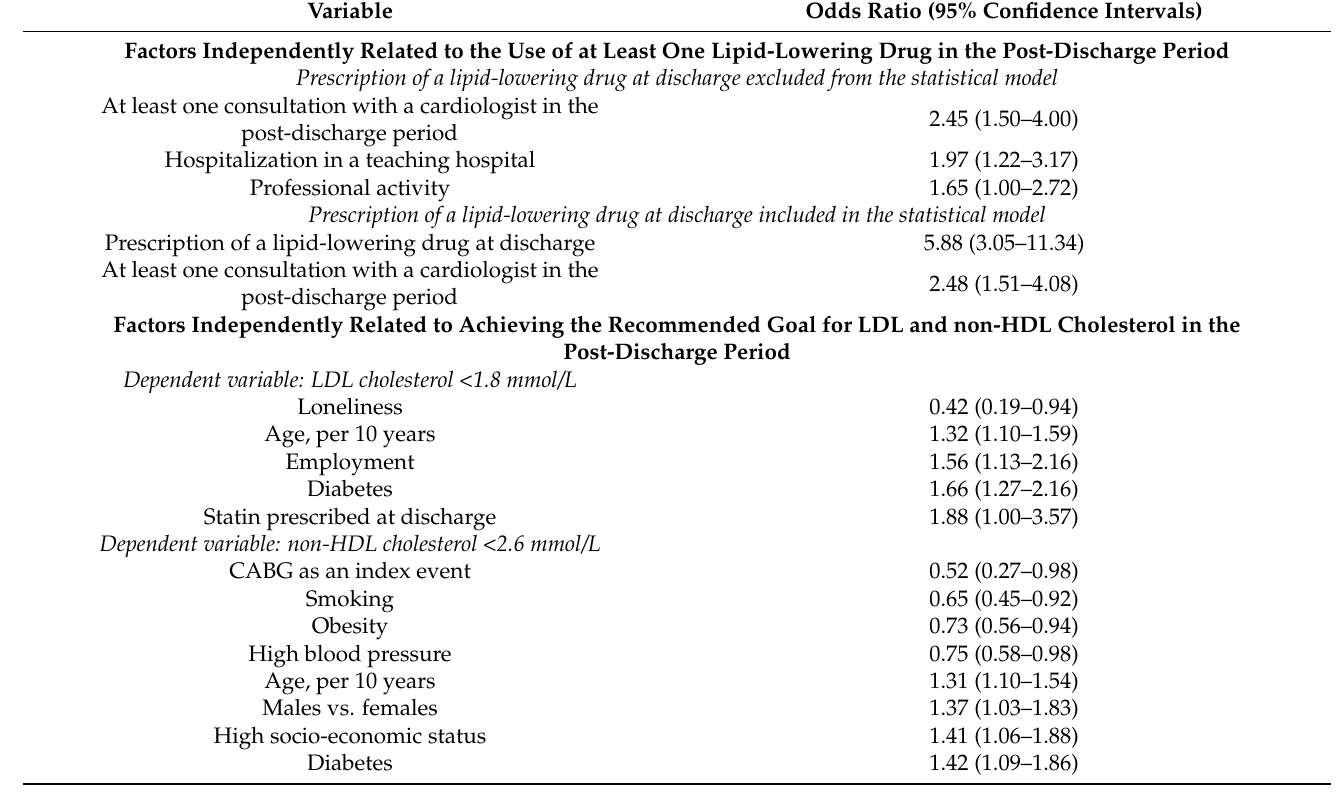
Table 4. Factors independently related to the use of at least one lipid-lowering drug and to achieving the recommended goal for LDL and non-HDL cholesterol in the post-discharge